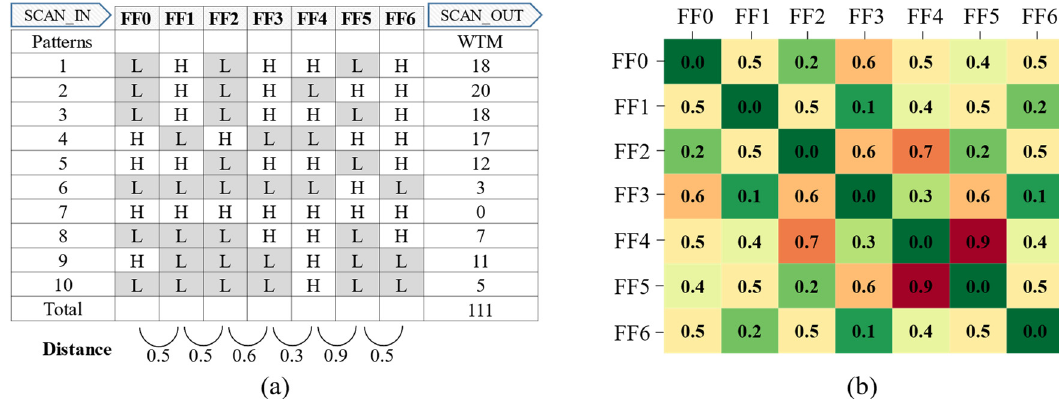
Figure 7. ( a ) WTM of example response vector with conventional stitching applied. ( b ) Distance matrix of scan cells in example response vector.